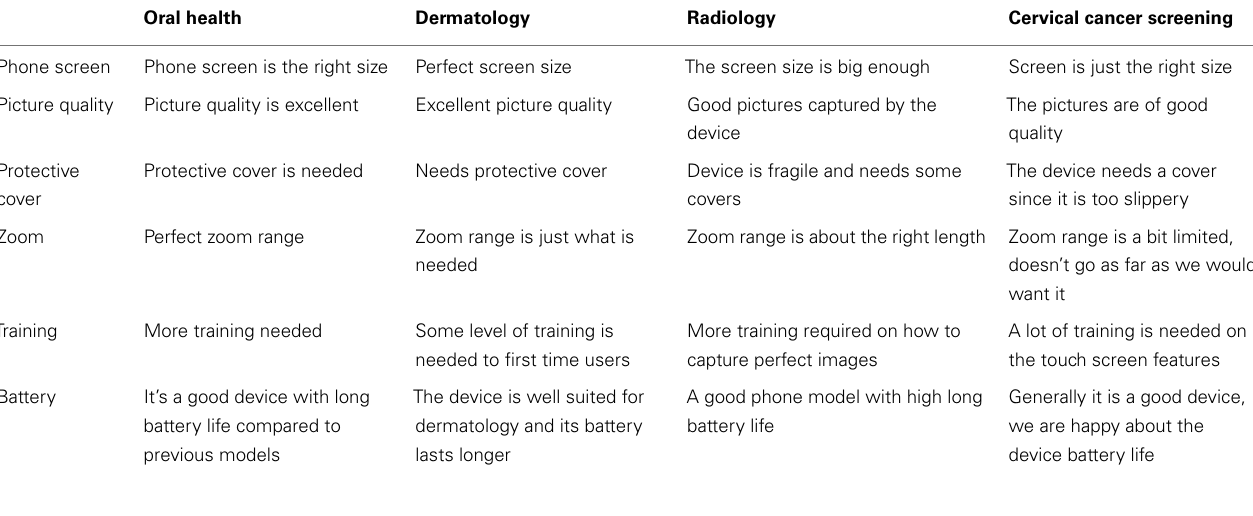
Table 2 | Summary of phone users’ feedback across the four medical specialties